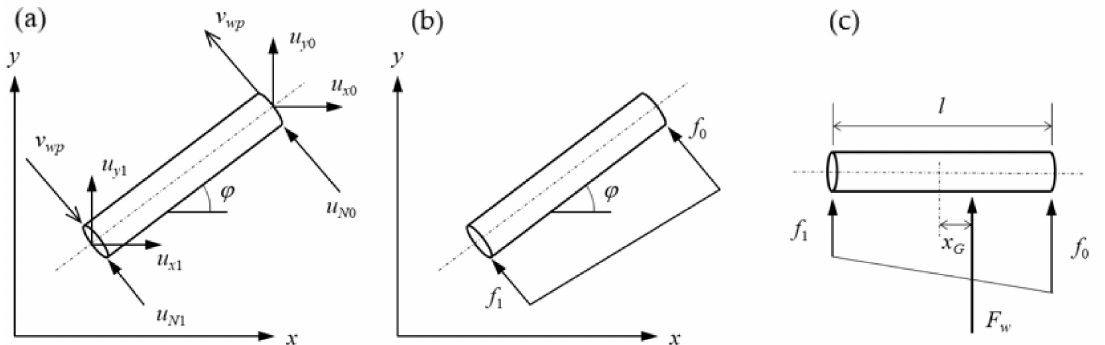
Figure 2. Definitions of driftwood properties, flow velocity, and forces acting on wood pieces modeled as a cylinder. ( a ) Flow velocities acting on edge of cylinder, ( b ) force distribution, and ( c ) moment